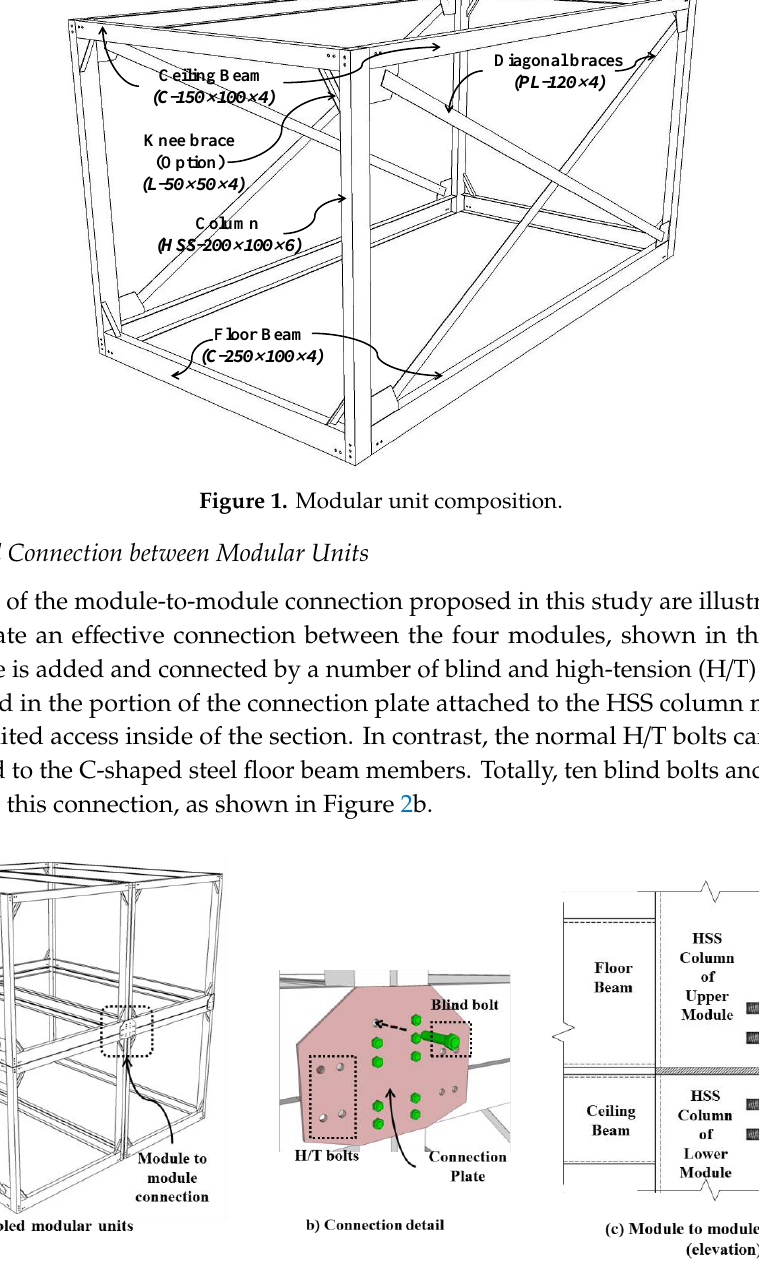
Figure 1. Modular unit composition.